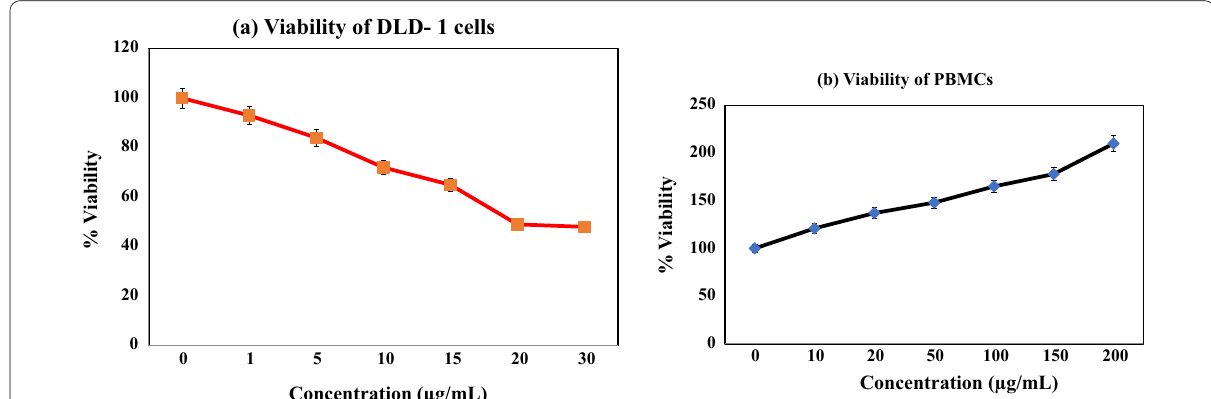
Fig. 5 a Graph representing the viability of DLD-1 cells after treatment with the extract fraction by MTT assay. The IC50 of the plant extract fraction was observed to be 18 µg/mL. b The extract had no cytotoxic effect on normal PBMCs thus, indicating the selective toxicity of the plant extract